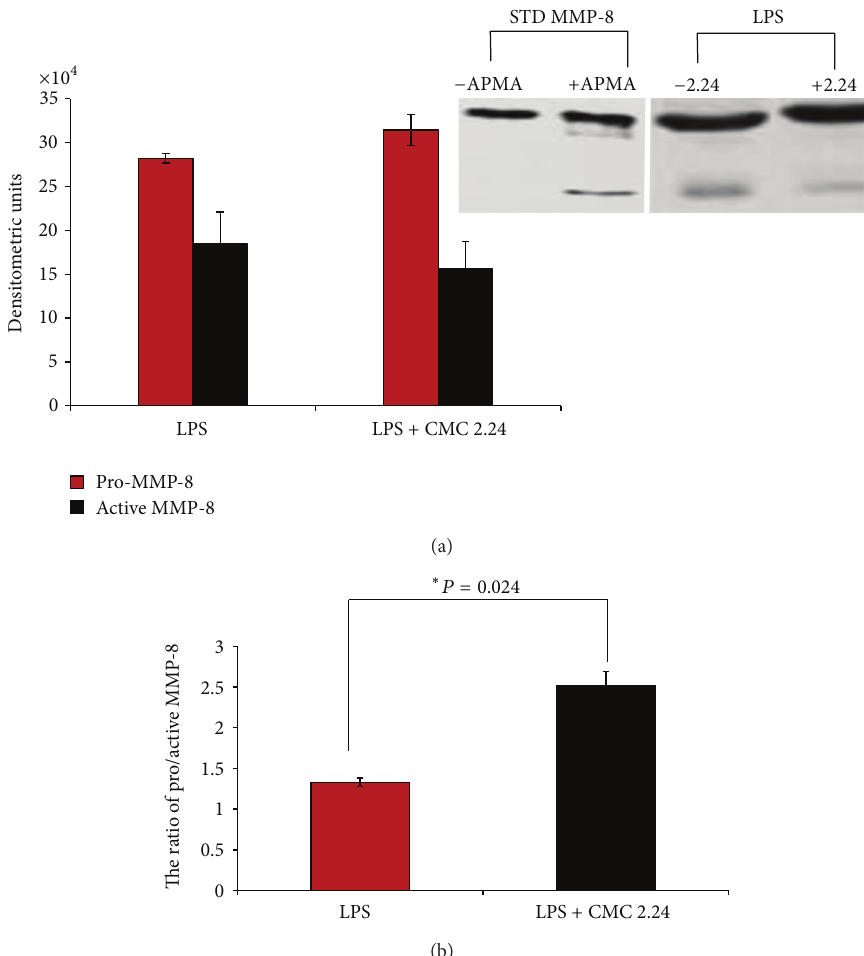
Figure 6: (a) Densitometric analysis of western blots of MMP-8 in plasma from untreated LPS- injected rats (LPS) and LPS-injected rats treated with CMC 2.24 (LPS + CMC 2.24). Each value represents the mean of MMP-8 ± the standard error of the mean (SEM); representative western blots of MMP-8 in plasma from untreated and CMC 2.24-treated rats are shown in the insert. (b) The ratio of pro/active MMP-8 calculated from densitometric analysis shown in (a)